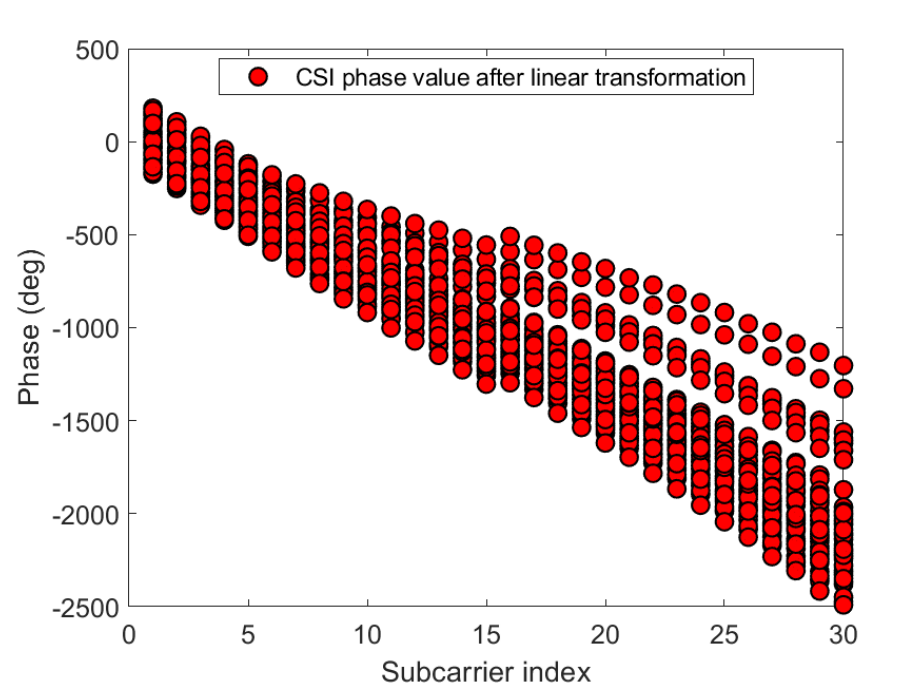
Figure 14. The phases after linear transformation of the 30 CSI sub-carriers on antenna a at reference point (0,1) of AP1 in the corridor of IT1 building.